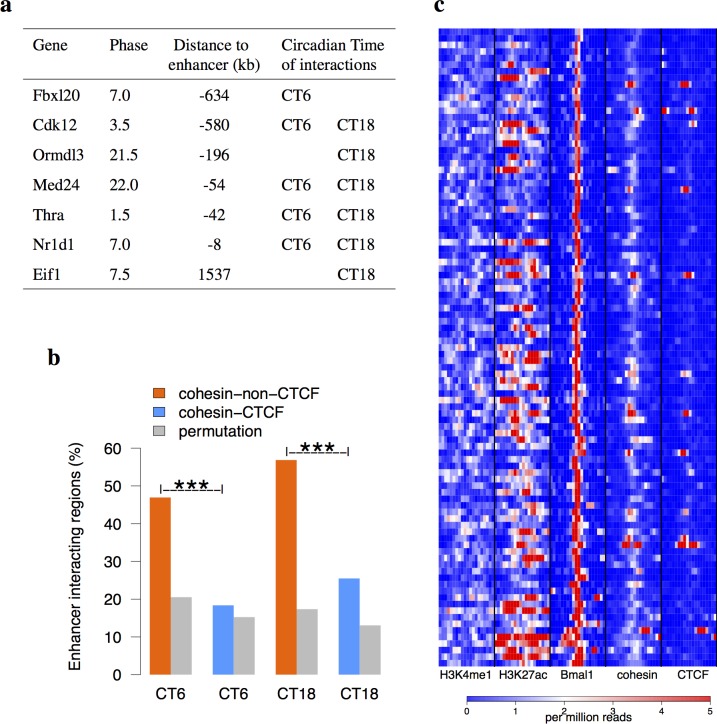
Cohesin is involved in circadian interactome.(a) The COGs in mouse liver interacting with the enhancer at CT6 or CT18. Their circadian phases and distances to the bait were listed. (b) The enhancer interacting regions significantly overlap more with the binding sites of cohesin-non-CTCF than cohesin-CTCF and randomly permutated cohesin-CTCF or cohesin-non-CTCF sites at both time points (binomial test). These two binding sites were identified from de novo analysis of ChIP-Seq data [22] (Methods). (c) The H3K4me1, H3K27ac [31], cohesin, and CTCF [22] ChIP-Seq signals around 97 Bmal1 super-enhancers. The binding sites were sorted by the signals on Bmal1 ChIP-Seq data [6]. The Bmal1 super-enhancers contain higher binding signals of cohesin than CTCF. ***p < 10−4.